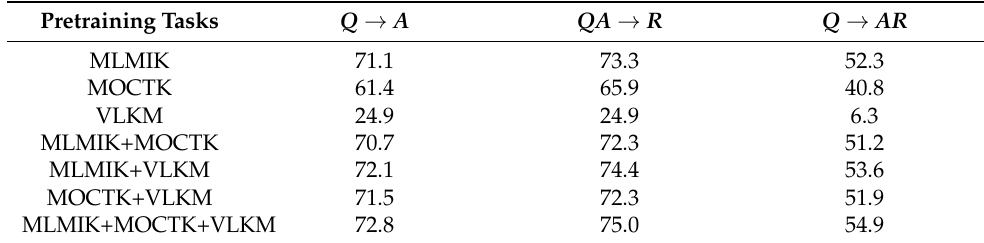
Table 3. Comparison between the pretraining tasks.